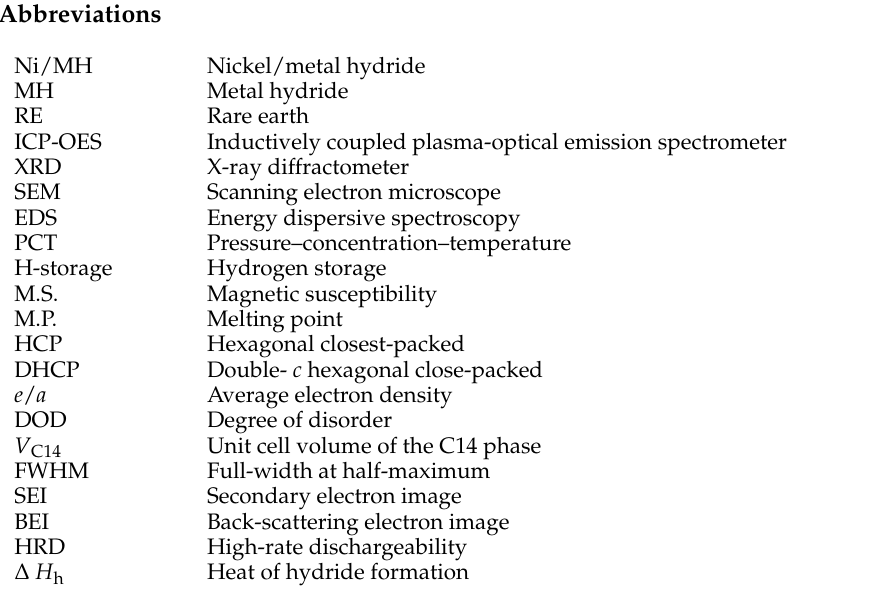
Figure 17. Evolutions of ( a ) saturated magnetic susceptibility and ( b ) strength of the applied field corresponding to half of the saturated magnetic susceptibility with increasing RE-content in the design.